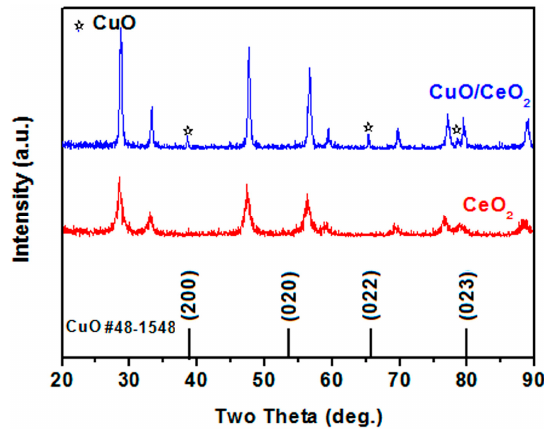
Figure 3. X ‐ ray diffraction (XRD) patterns of CeO 2 and CuO/CeO 2 nanocomposite.